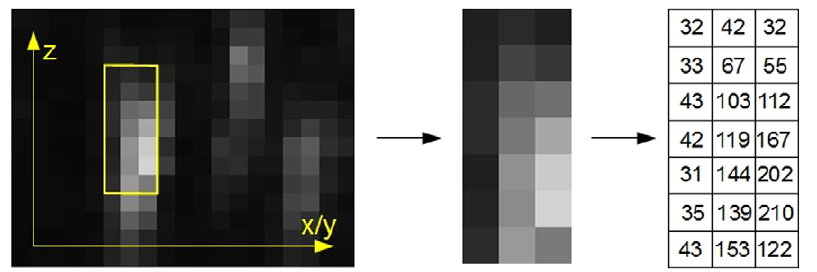
Figure 7. Adaptive template generation. Random sub-sections (yellow window) are selected from the 2D slices of the input stack. They are weighted with the intensity of the central pixel (right side) and then averaged to obtain a representative template for fiber cross sections.